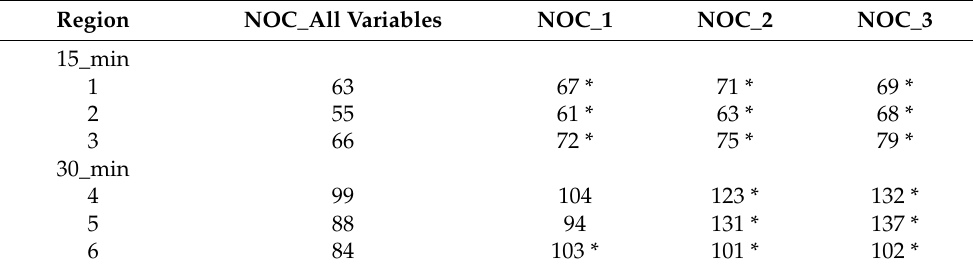
Table 4. Daily mean absolute error in minutes for NOC models with data reduction.